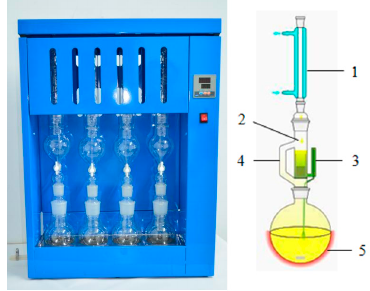
Figure 1. Soxhlet Extractor. Note: 1: condenser tube; 2: extraction tube; 3: siphon tube; 4: connection tube; 5: extraction flask.